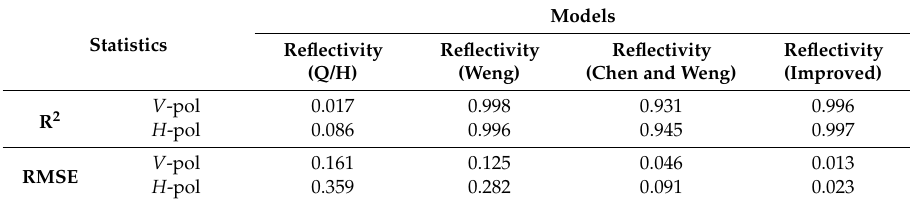
Table 2. Statistics for comparisons of the Q / H , Weng, Chen and Weng, and the parameterized soil surface emissivity model with the AIEM simulations ( V -pol: vertical polarization, H -pol: horizontal